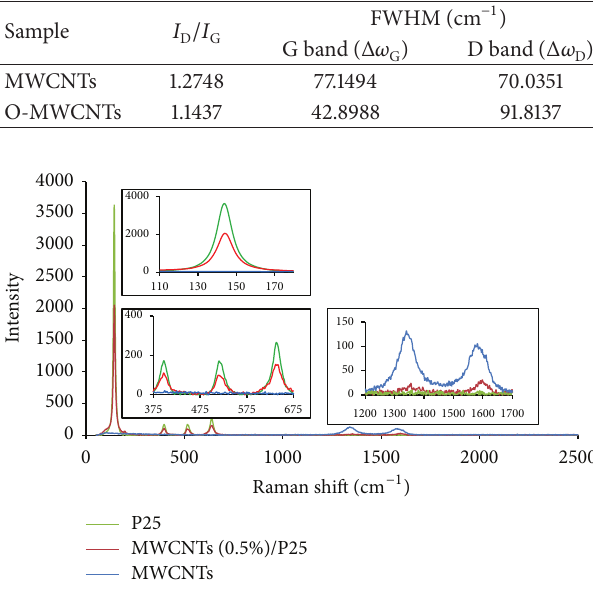
Figure 4: Raman spectra for P25, MWCNTs (0.5%)/P25, and MWCNTs.